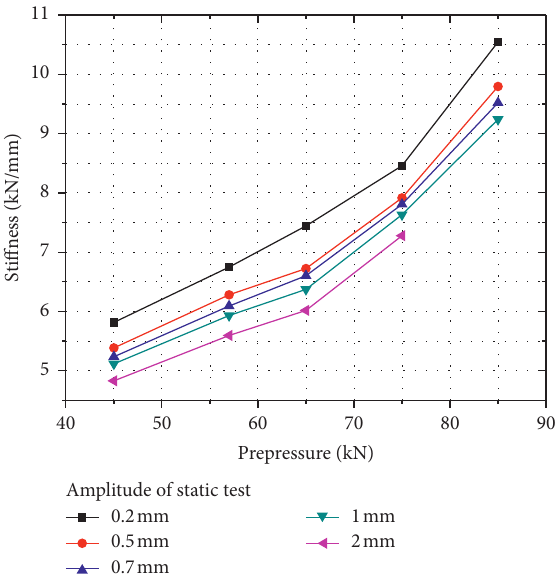
Figure 4: The curve of quasi-static stiffness with